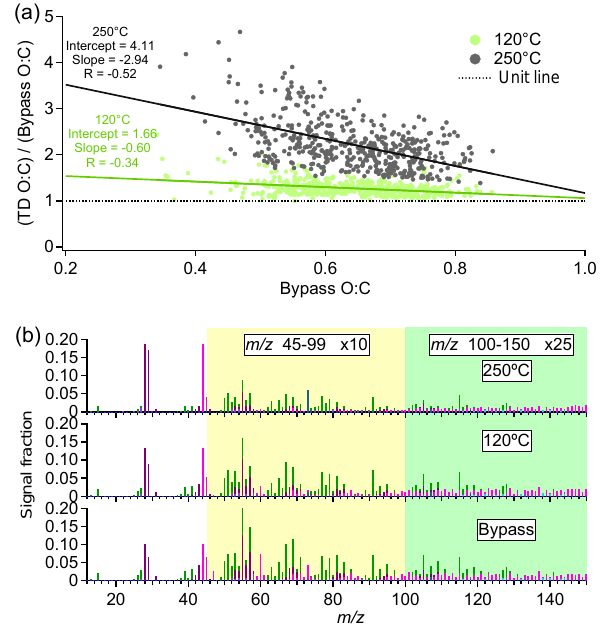
Figure 14. (a) O:C enhancement (i.e., ratio of TD line O:C to bypass line O:C) as a function of bypass line O:C. (b) Mass spectra of OA under different TD temperatures. The signals be- tween m/z 45 and 99 are multiplied by 10 and the signals between m/z 100 and 150 are multiplied by 25 for clarity. The mass spectra are colored by the ion type in the same way as Fig.